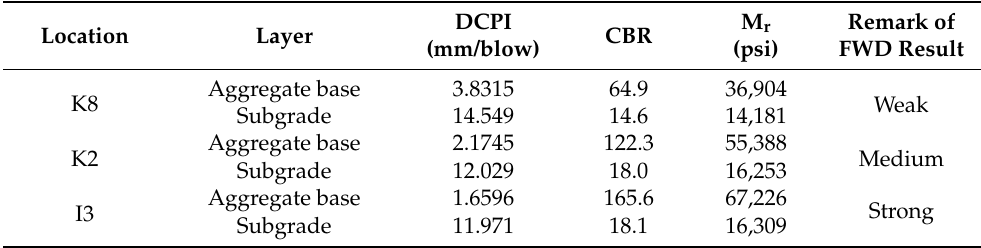
Table 2. Back-calculated properties of support layers by DCP results. (1 psi = 6.89 kPa). DCP index (DCPI), DCP index. Location